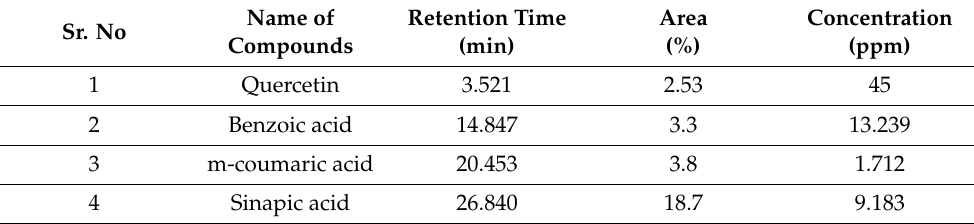
Table 1. HPLC screening of phenolics and flavonoids compounds (ppm) of aqueous fractions of methanolic extract of Lentinula edodes.